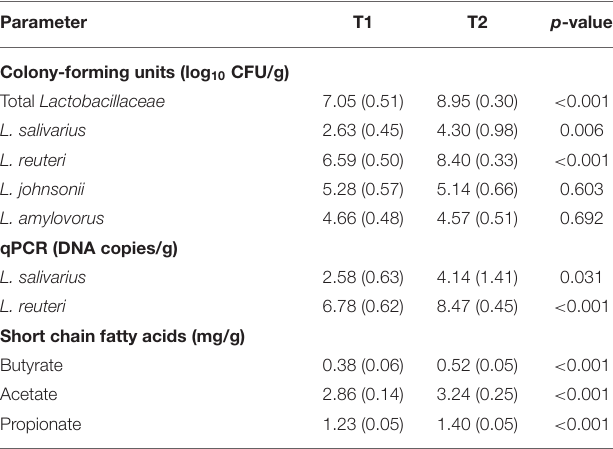
TABLE 3 | Microbiological and biochemical parameters, expressed as mean ( ± SD), in the feces of 8-week-old piglets ( n = 15) in the farm under study before (T1) and after 2 years (T2) of supplementation with L. salivarius MP100.